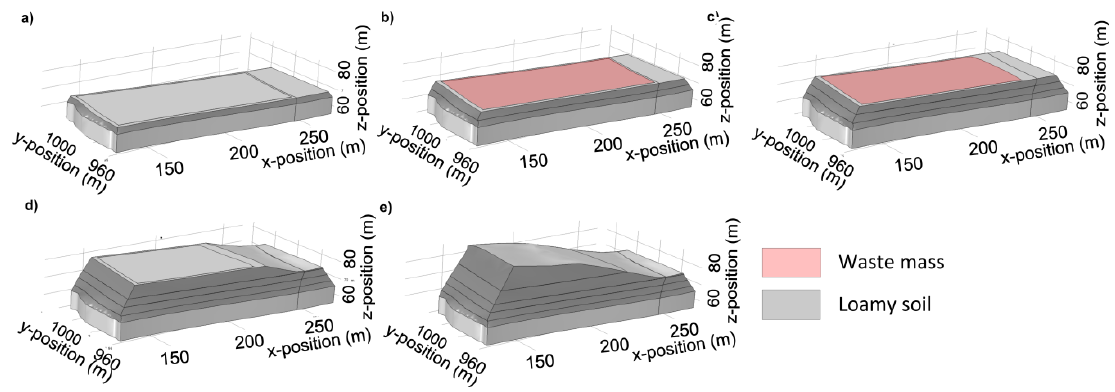
Figure 3. Evolution of the waste geometry over time: ( a ) 0 to 59 days, ( b ) 60 to 119 days, ( c ) 120 to 179 days, ( d ) 180 to 239 days and ( e ) 240 to the end.